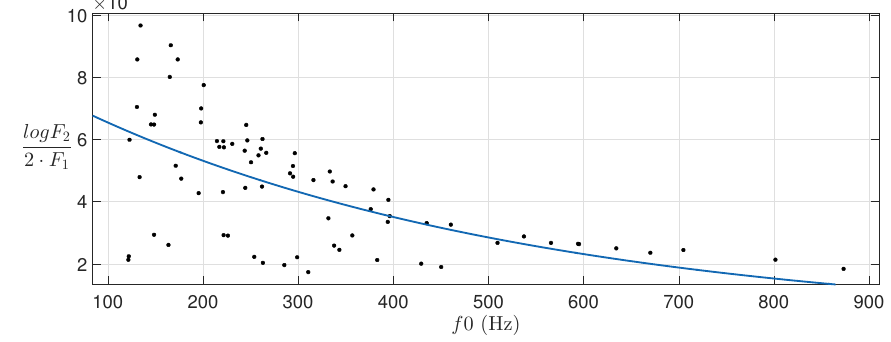
Figure 4. F 2 evolution with pitch, harmonic component.